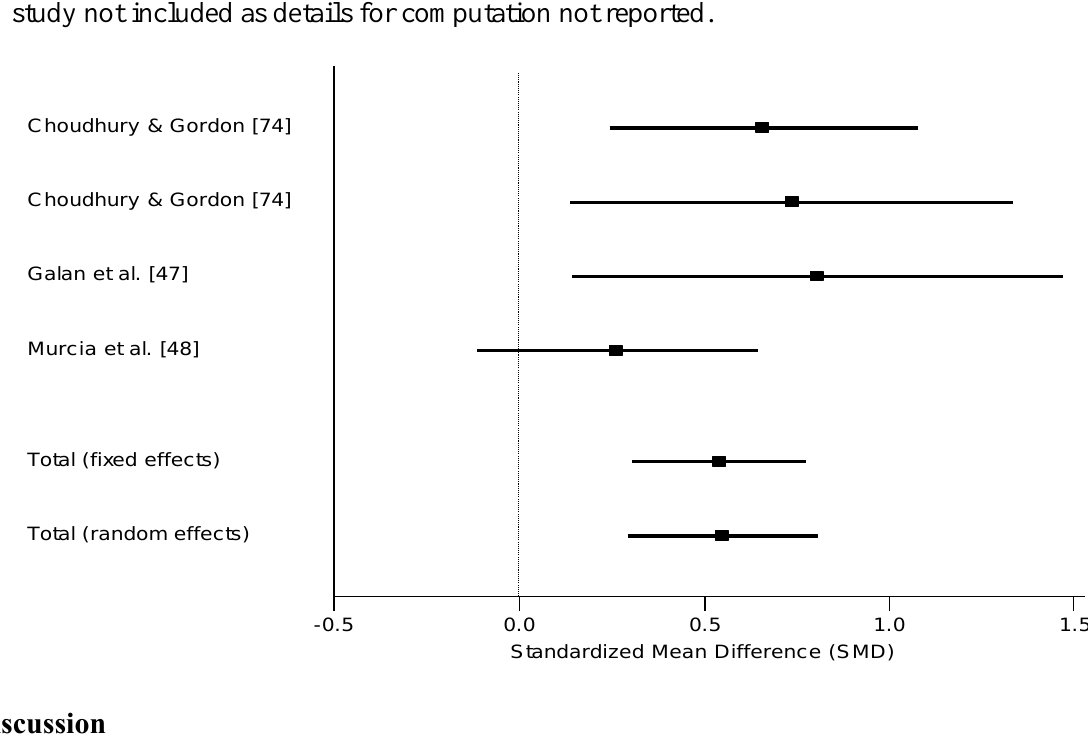
Figure 4. Forest plot for effect size (Standard mean difference SMD and 95% confidence interval) of iodine on mental development of children, cohort prospective studies stratified by newborn iodine status. The studies were homogeneous ( Q = 3.44, df = 3, p > 0.05). The fixed effects model was therefore more appropriate. Estimated effect size of 0.1 in Oken’s study not included as details for computation not